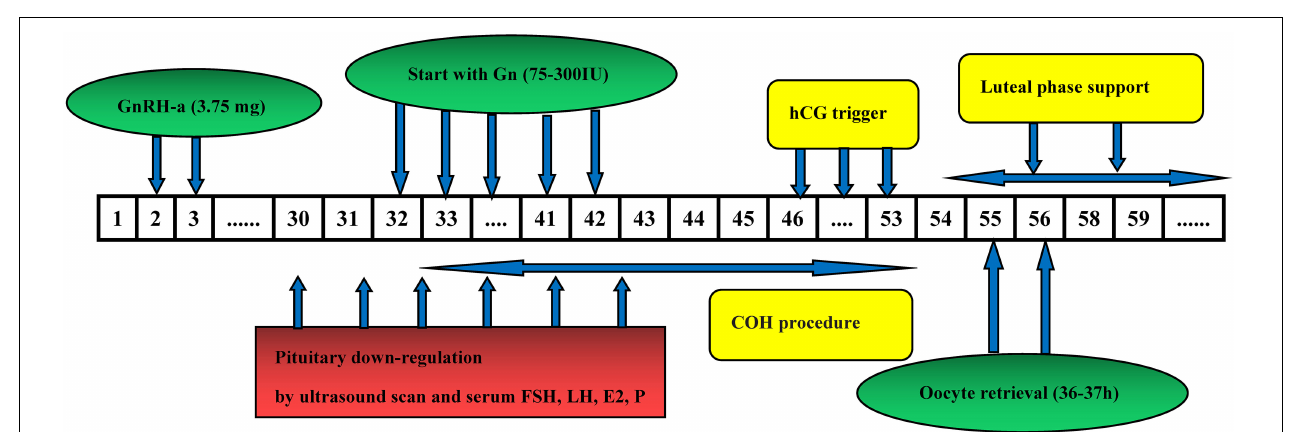
FIGURE 2 | The flow chart of Early follicular phase long-acting GnRH agonist long protocol.